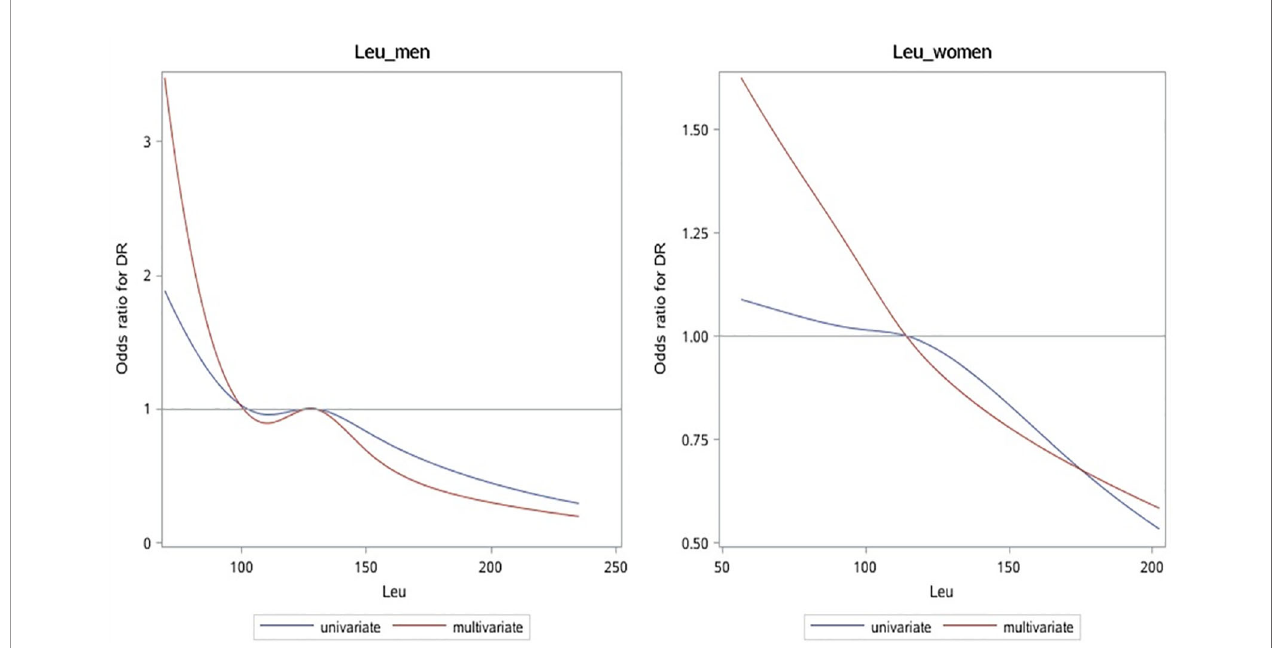
FIGURE 2 | OR curves of leu and DR in patients with T2D of different genders. The blue solid line represents the curve with only leu in the model, and the red dotted line represents the curve after adjusting for all baseline data, laboratory test indicators, and complications. It can be seen that leu is a protective factor of DR. OR, odds ratio; leu, leucine; DR, diabetic retinopathy; T2D, type 2 diabetes.